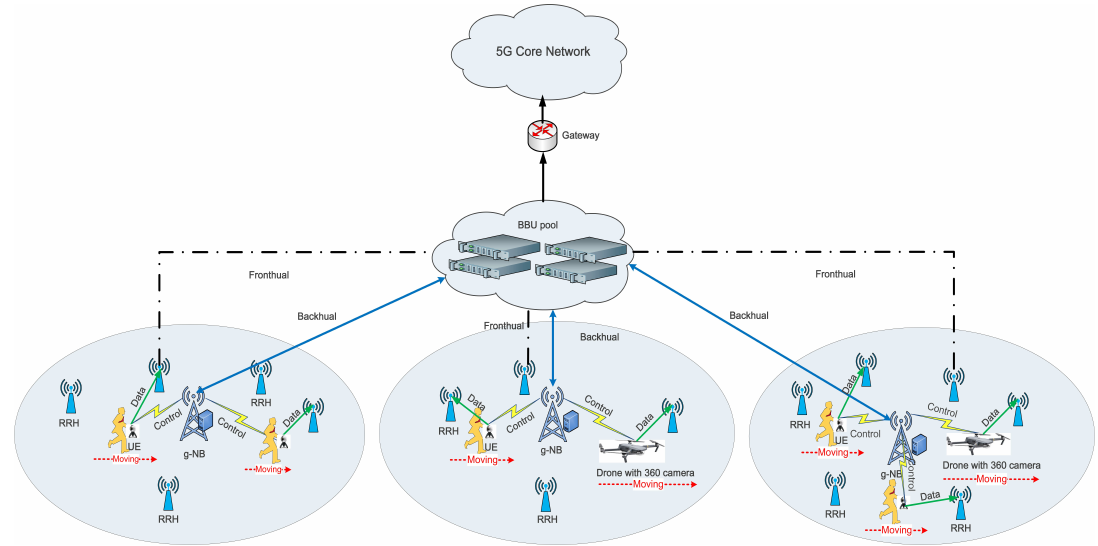
Figure 1. User generated VR video uploading in 5G